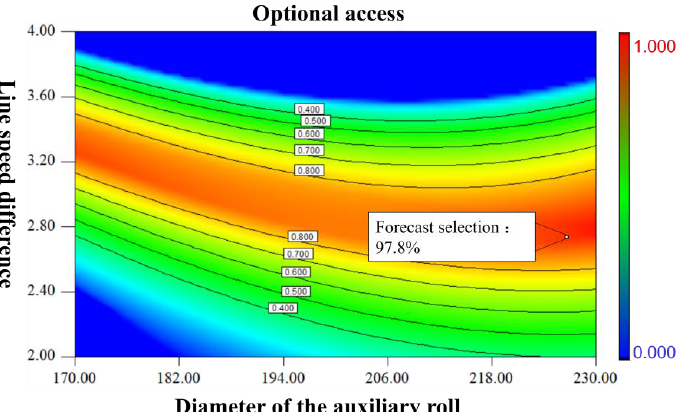
Figure 15. Parameters optimizing results.